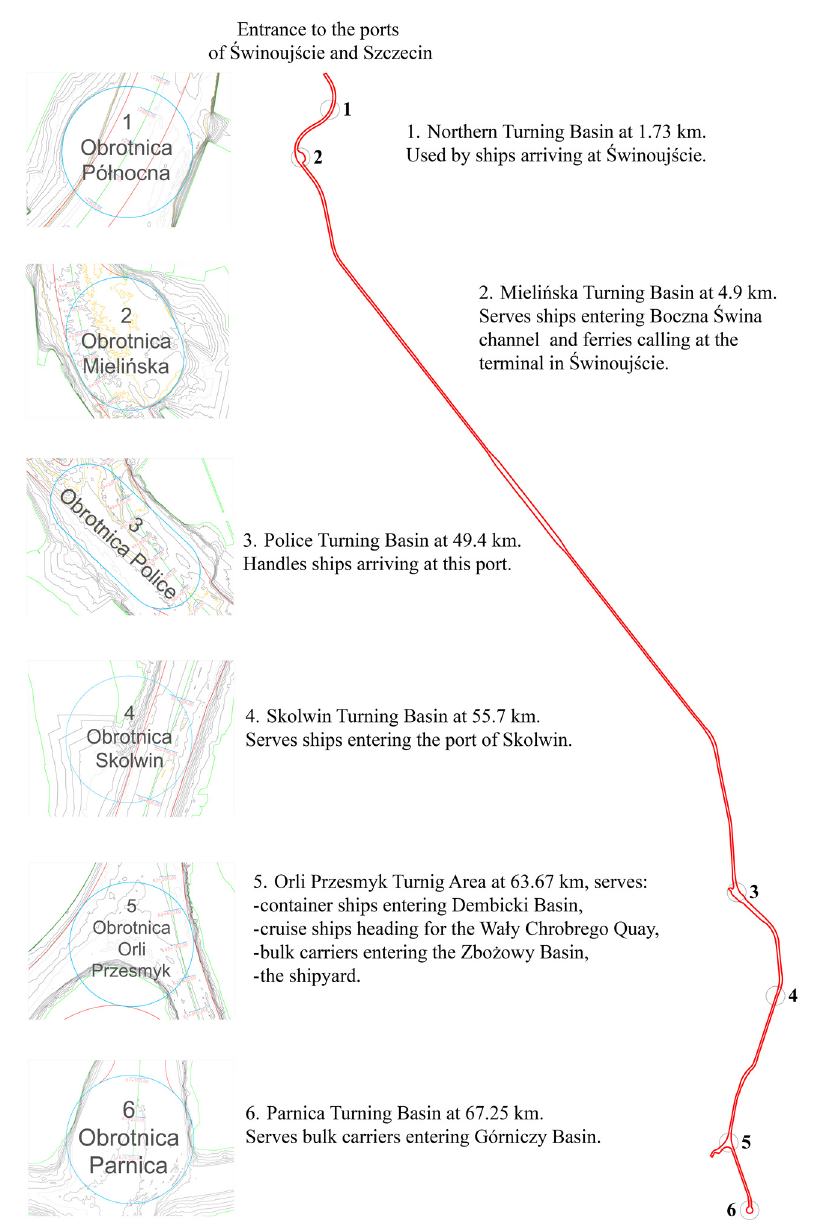
Figure 2. A simplified model of the complex port waterways system (four terminals).